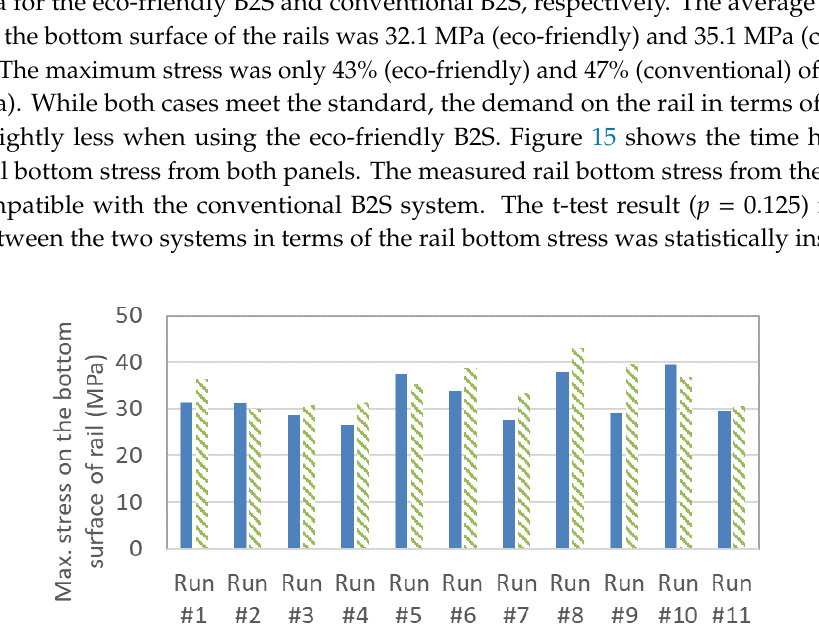
Figure 15. Time history of the stress on the bottom surface of rail: (a) conventional B2S and (b) eco- friendly B2S. 4.4. Accelerations and Noise Vertical accelerations on the B2S panels and lateral accelerations on the tunnel wall were monitored. Figure 16 shows the comparison of the vertical acceleration between the eco-friendly B2S and the conventional B2S. Some of the acceleration records from the conventional B2S were slightly higher than those obtained from the eco-friendly B2S. The average vertical acceleration was found to be 0.0318 g and 0.0361 g for the eco-friendly and the conventional B2S, respectively. In addition, Figure 17 shows the comparison of the lateral acceleration on the tunnel walls. The average lateral acceleration was 0.0156 g (eco-friendly) and 0.0152 g (conventional). The difference in the lateral accelerations was relatively small. The t -test results on the vertical acceleration and the lateral acceleration were p = 0.256 and p = 0.808, respectively. Figure 18 shows the time history graphs of the vertical accelerations as an example. By using the eco-friendly B2S panels, the dynamic characteristics of the track structure did not significantly change. It is worthwhile to note that some of the data were lost during the field test (e.g., acceleration data from runs #7 and #11).